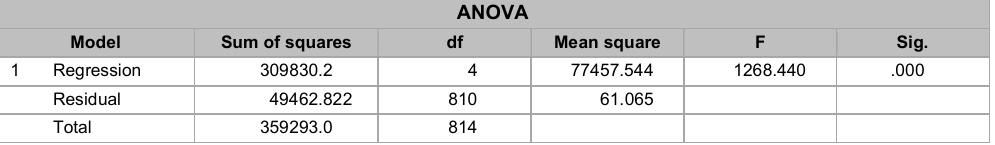
One-way analysis of variance (ANOVA) for clerical jobs ANOVA df Mean square F